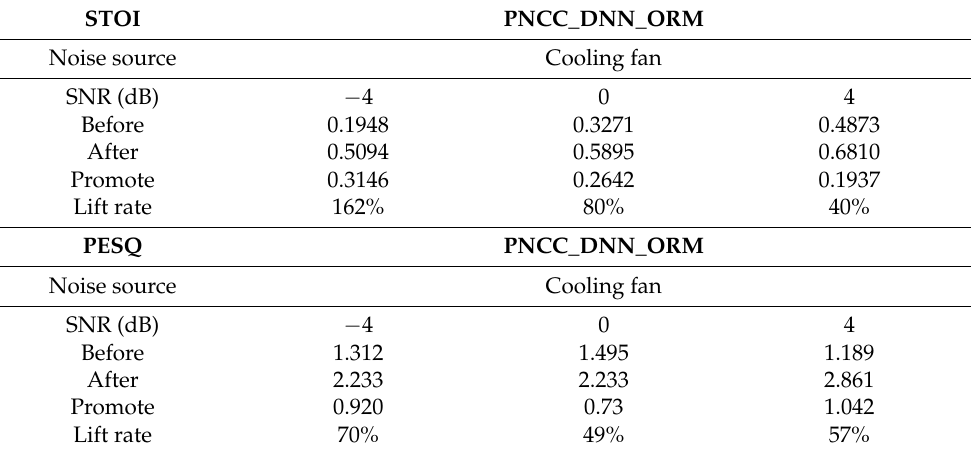
Table 9. Noise reduction effect of different